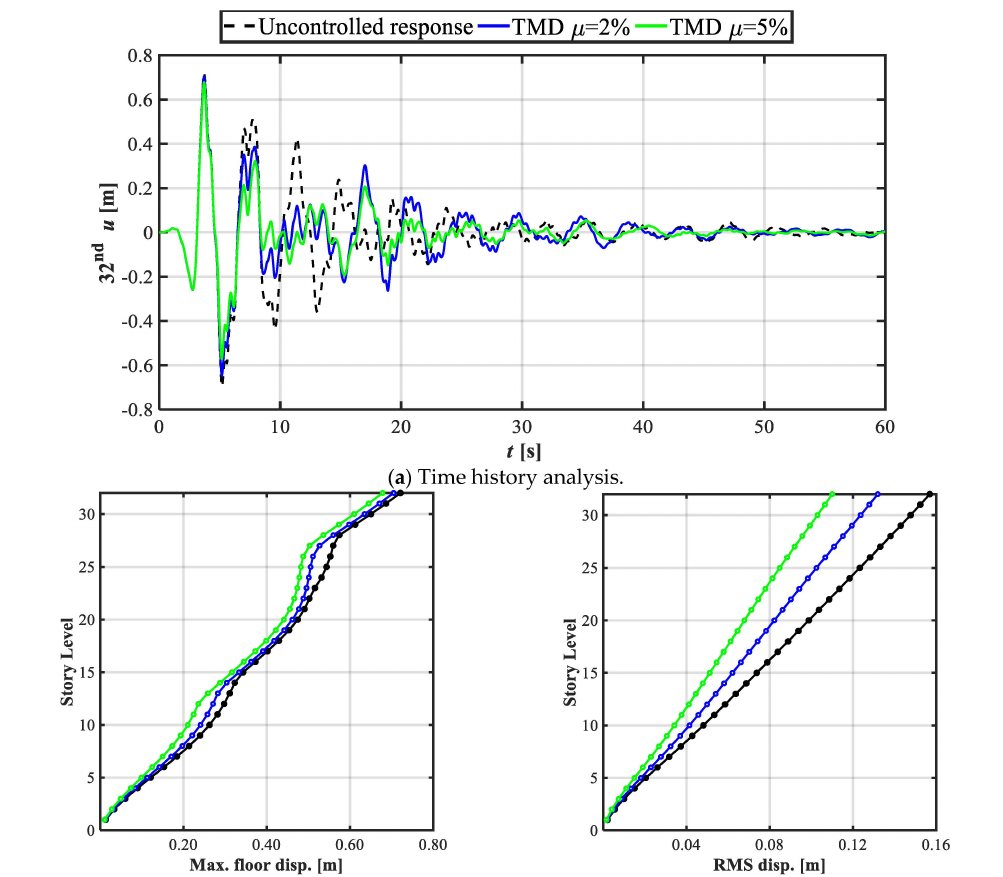
Figure 13. Performance of the structure equipped with TMDs with average design parameters subjected to Petrolia earthquake.